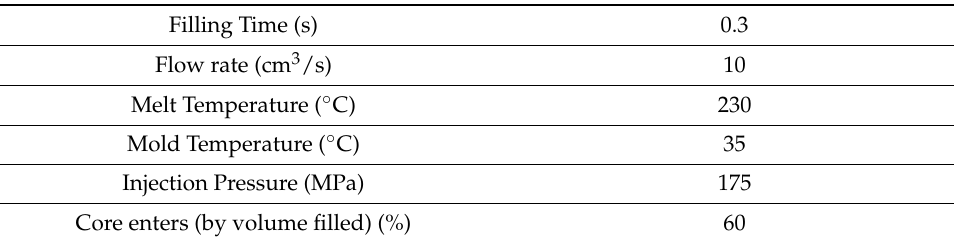
Figure 2. The shear viscosities of material PP and 30SFPP. Table 2. Process conditions for basic flow behavior